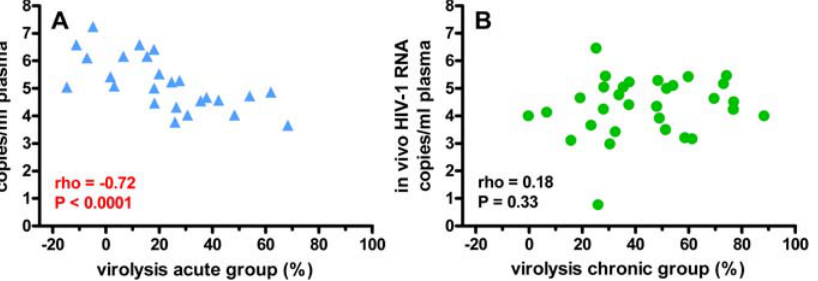
Figure 8. Correlation Analysis of Complement Virolysis and In Vivo Viremia Levels In vitro-determined autologous virolysis activity was correlated with in vivo HIV-1 RNA copies measured per milliliter of plasma in the acutely infected group (A) and the chronically infected group (B). Correlations were evaluated using Spearman’s rank correlation. Our data demonstrate that increased antibody-mediated complement lysis coincides with lower viral loads in the acute phase. No evidence was found for a similar correlation in the chronically infected group.